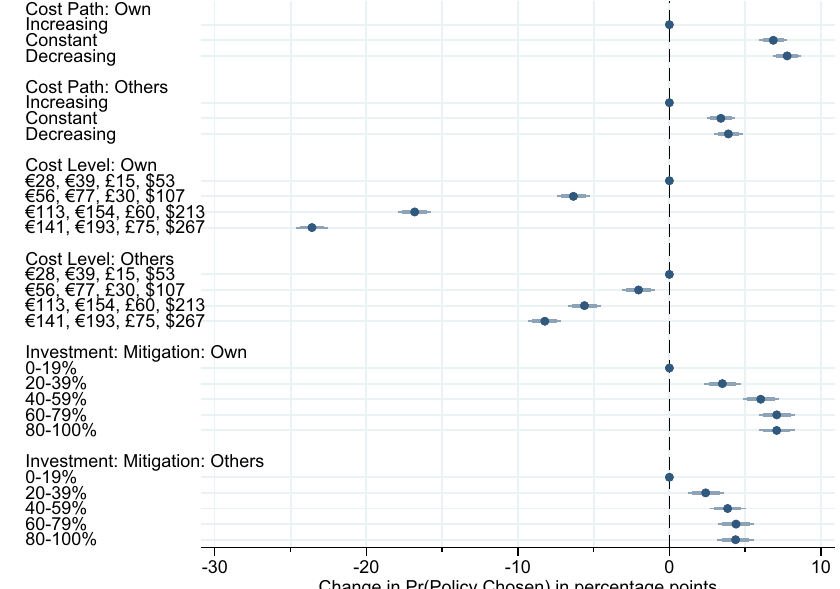
0 10 Change in Pr(Policy Chosen) in percentage points reference categories. Results for the unweighted data are very similar (see Sup- plementary Fig. 6) and quite stable across countries (see Supplementary Fig. 7). Results for each country separately are shown in Supplementary Fig. 6. N (France)=32,000, N (Germany)=32,000, N (UnitedKingdom)=32,000, N (United